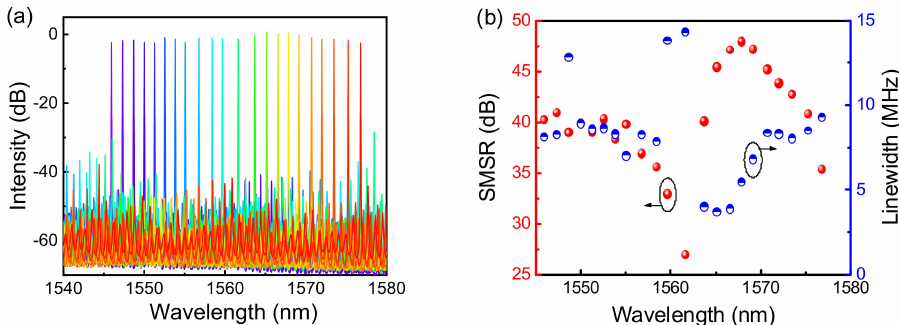
Figure 5. ( a ) Superimposed lasing spectra for HSRRLs and ( b ) the SMSR and linewidth in the entire tuning wavelength